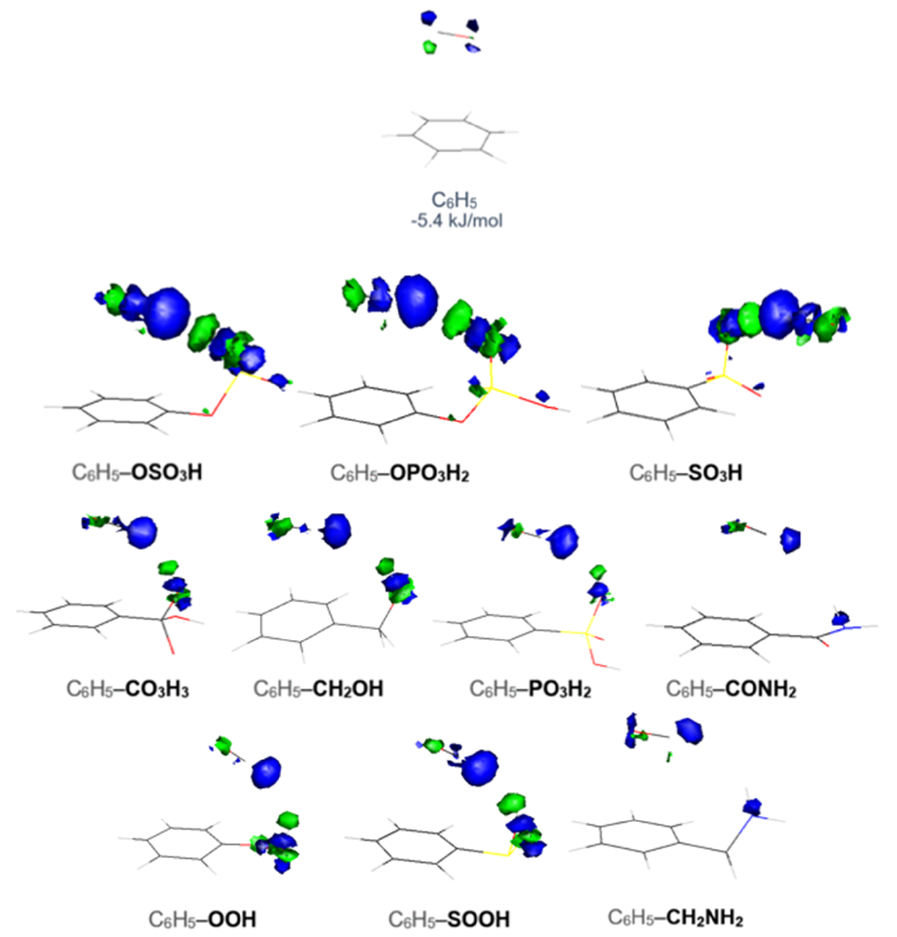
Figure 5. Electron-density redistribution plots of the optimized geometries of the strongest interacting CO · · · C 6 H 5 -X complexes. Blue and green regions that represent areas that gain or lose electron density, respectively.